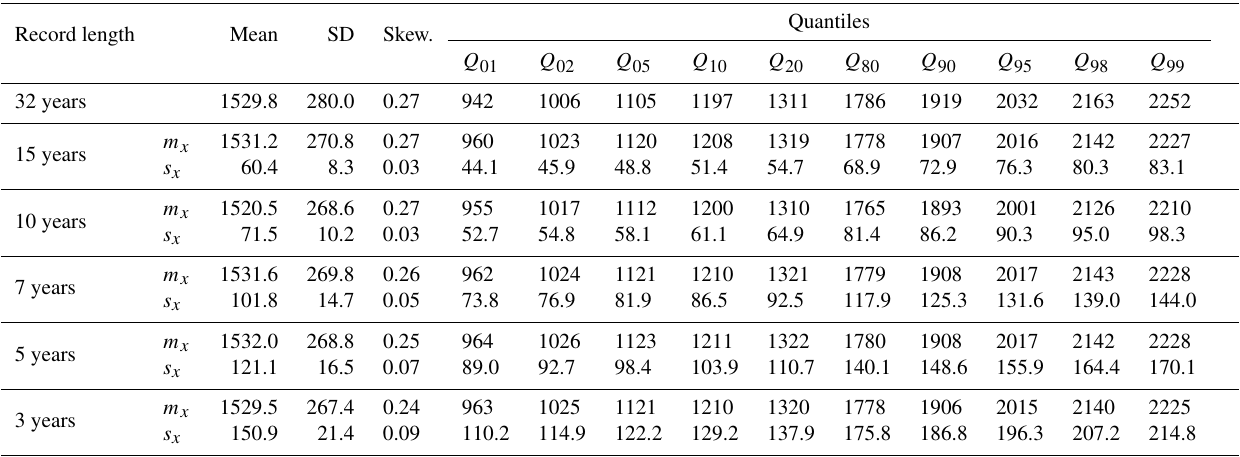
Table A3. Mean, standard deviation (SD), selected quantiles (in millimeters), and skewness of the annual rainfall in Lugano, as obtained with derived distributions for the 32-year complete record and for shorter, resampled records of lengths 15, 10, 7, 5, and 3 years ( m x and s x are the mean and standard deviation of each statistic for the 200 resampled records).